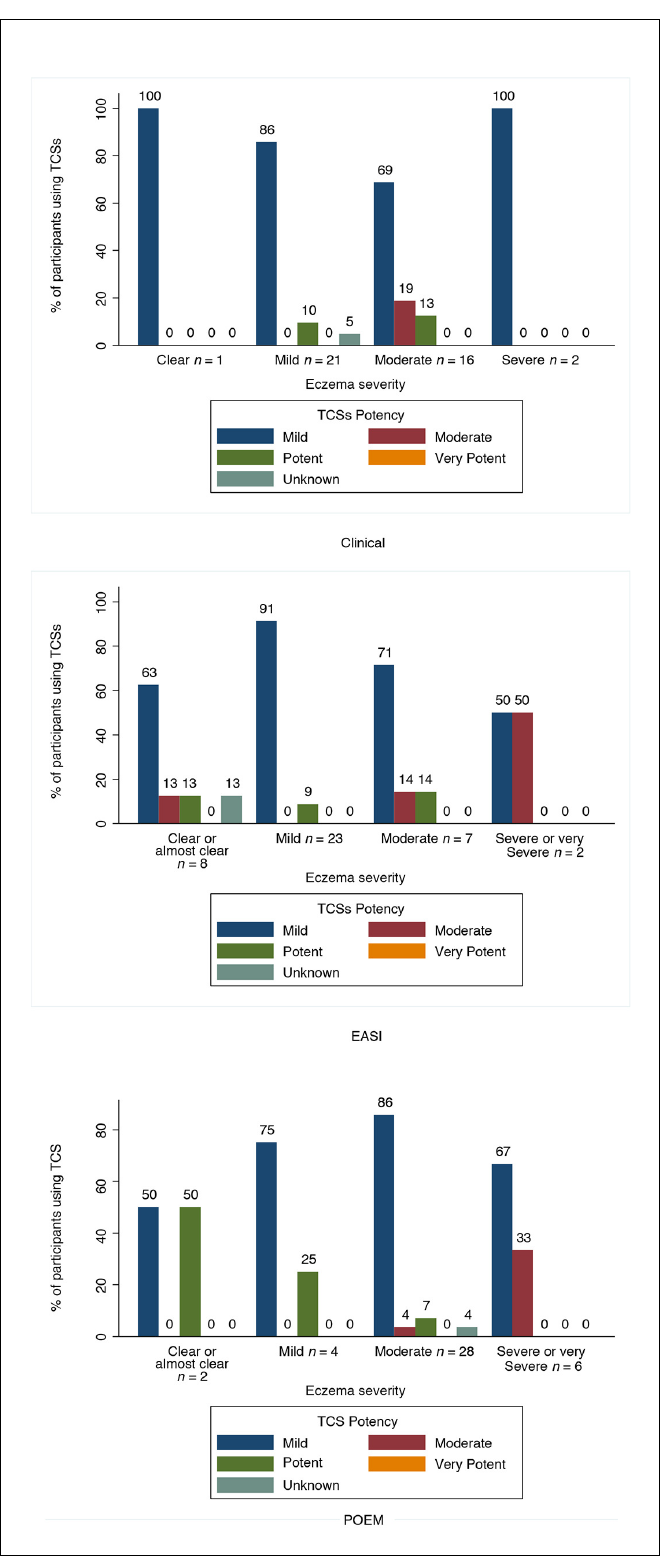
Figure 2. Topical corticosteroid use by categorical clinical, EASI, and POEM assessments of eczema severity. TCS = topical